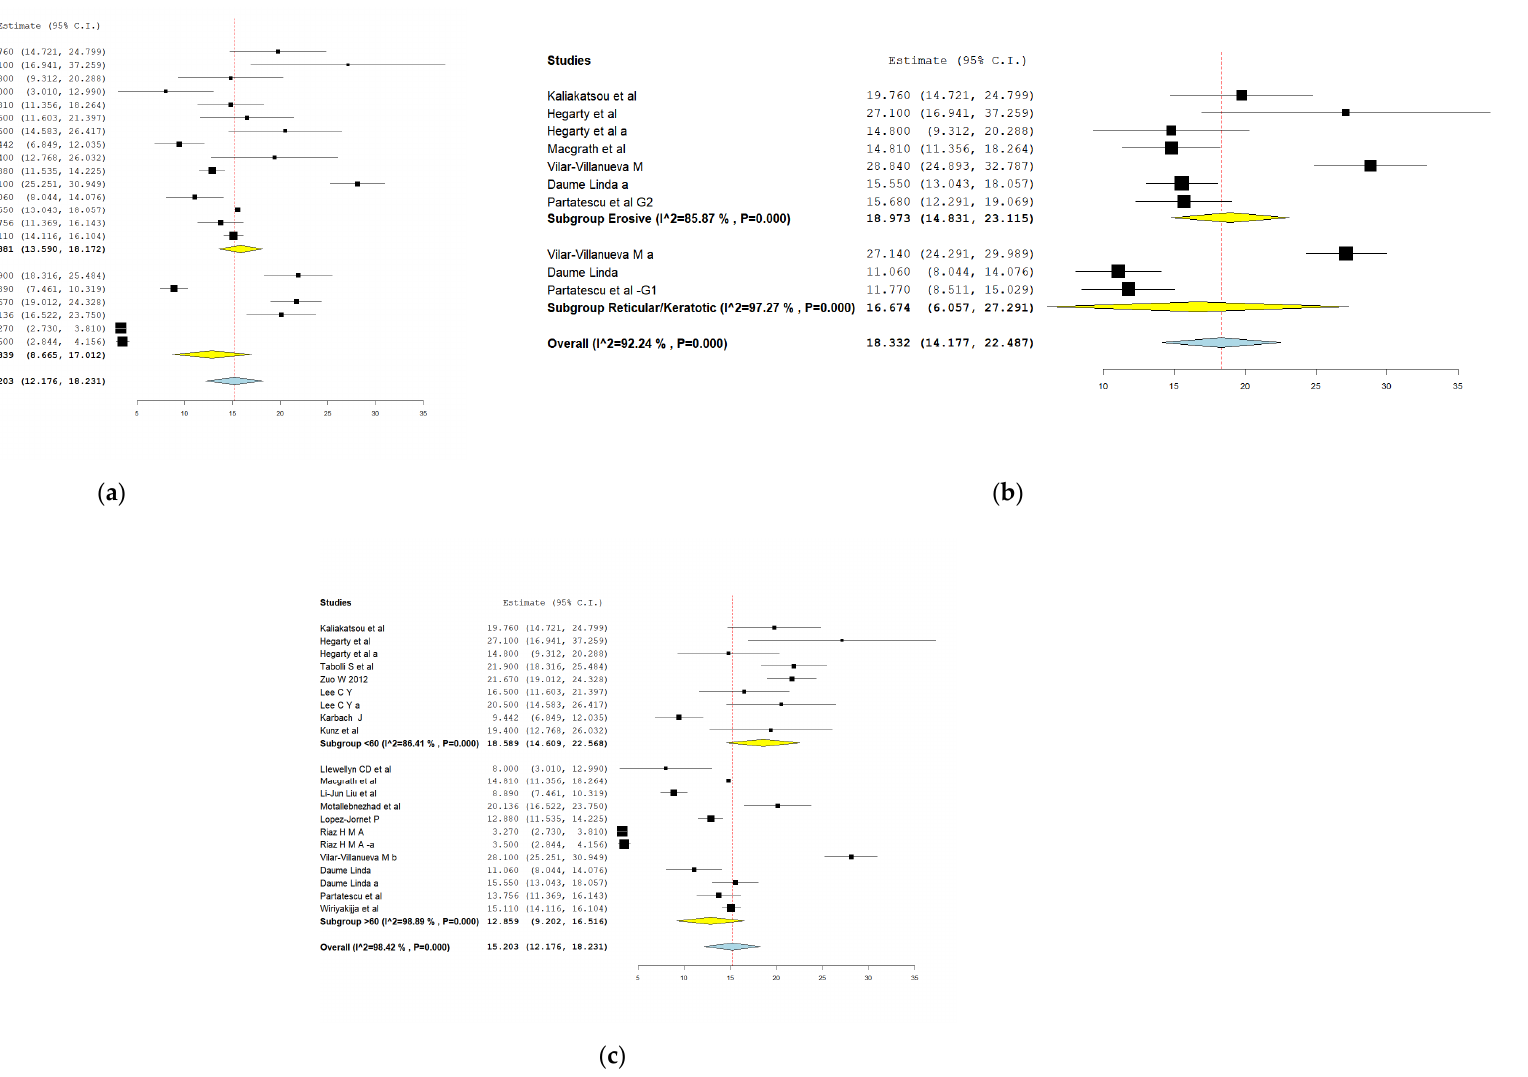
Figure 3. ( a ): Subgroup analysis based on age. ( b ): Subgroup analysis based on clinical type. ( c ): Subgroup analysis based on female proportion in the